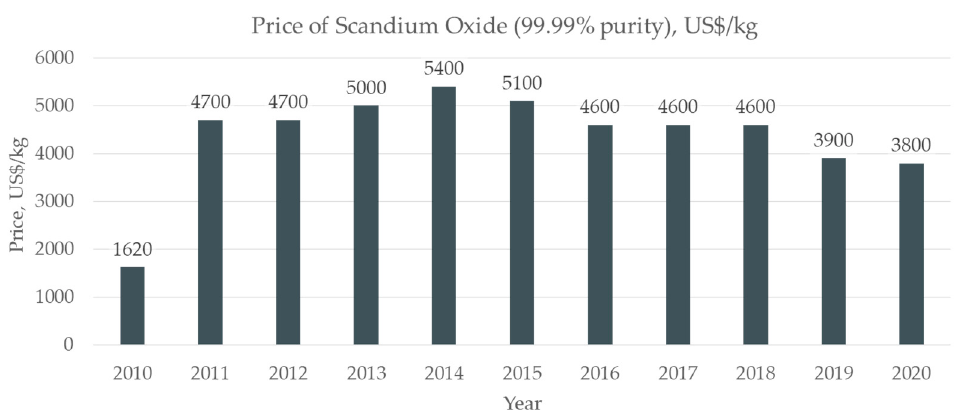
Figure 1. Price of scandium oxide US$/kg, data from [6–8].